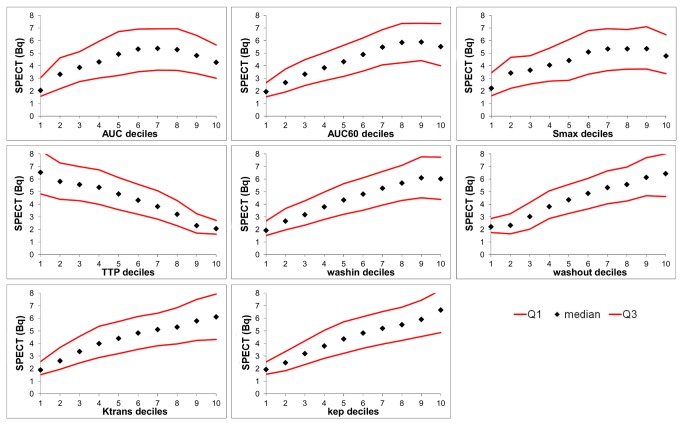
DCE-MRI parameter decile groups with corresponding median SPECT-peptide uptake values.The median, Q1, and Q3 SPECT values (Bq) for the different DCE-MRI parameter decile bins for one tumor. AUC, area under the whole curve; AUC60, area under the curve for the first 60 s; Smax, maximum enhancement; TTP, time to peak; wash-in, slope between the 10% point and the 90% point on the enhancement curve [19]; wash-out, slope between the point of maximum enhancement and the last time point [19]; Ktrans (s-1) capillary transfer constant [20]; kep (s-1), contrast exchange rate [20].